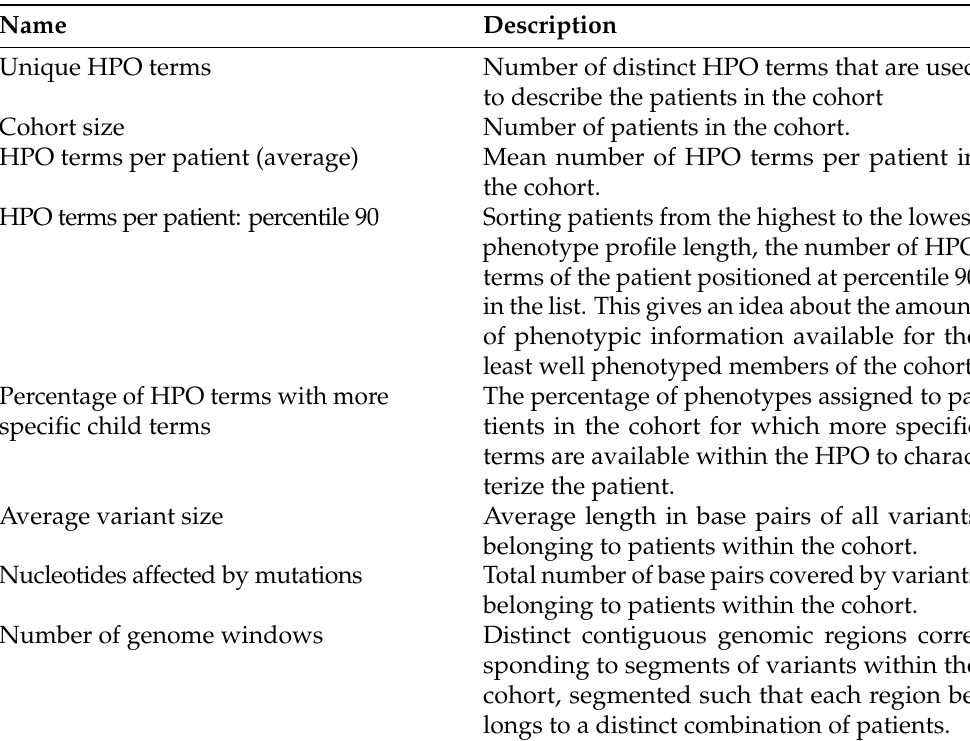
Table 1. Cohort Analyzer general summary